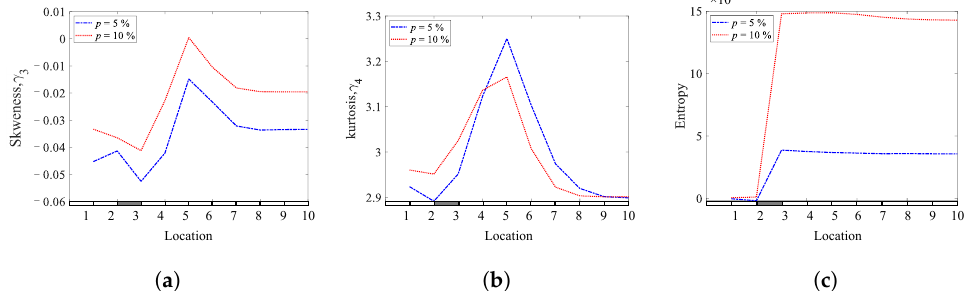
Figure 22. A breathing crack identification of a cantilever beam at two small crack depths and at crack location of q 1 = 0.25: ( a ) Skewness; ( b ) Kurtosis; ( c ) Shannon